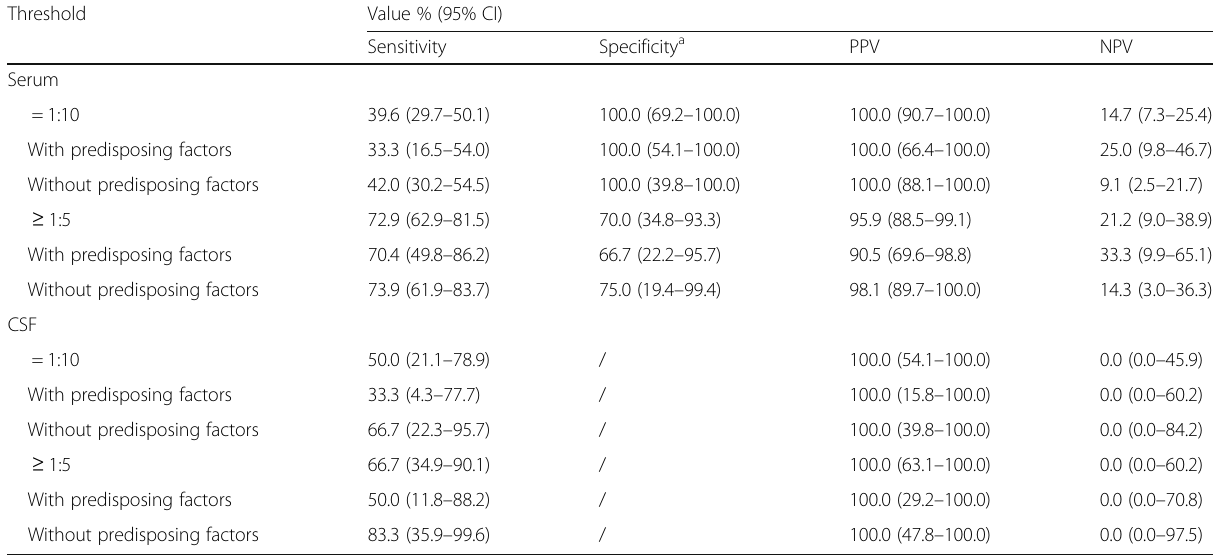
Table 3 Diagnostic accuracy of different low CrAg LFA titers in patients with different immune status